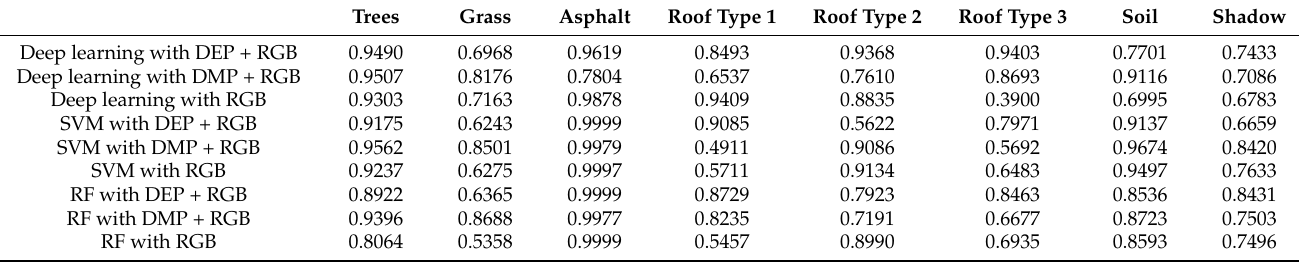
Table 10. The f-score measure for all classes in World-View 2 dataset. Trees Grass